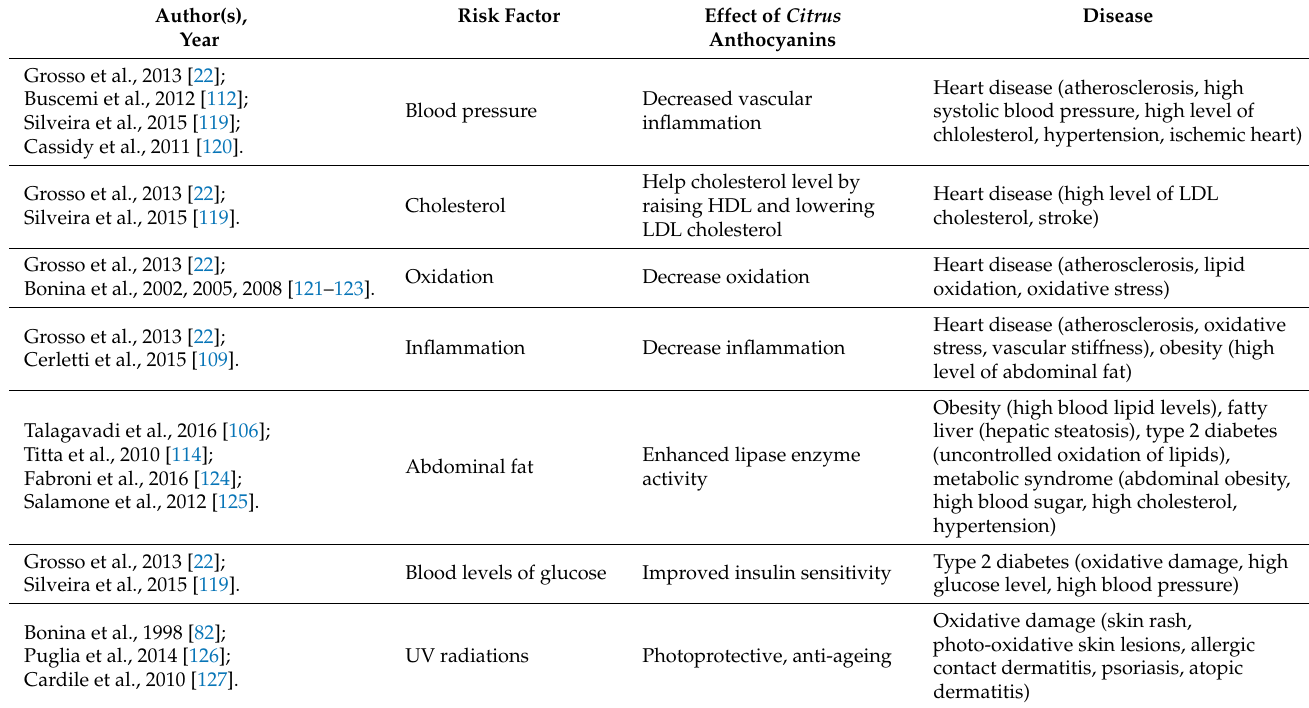
Table 3. Citrus anthocyanins and their positive health